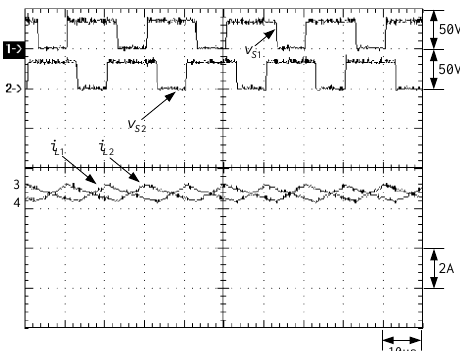
Figure 34. Waveforms pertaining to current balancing at the rated load: (1) v S 1 ; (2) v S 2 ; (3) i L 1 ; and (4) i L 2 .